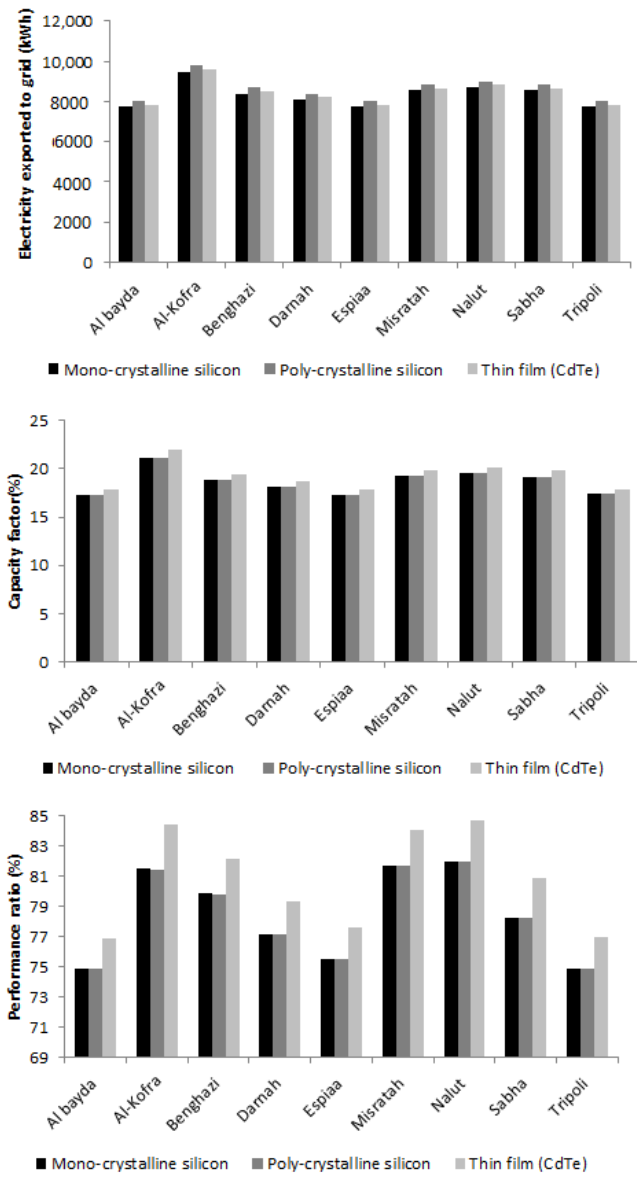
Table 10. Optimum angles for the PV system for all selected regions.